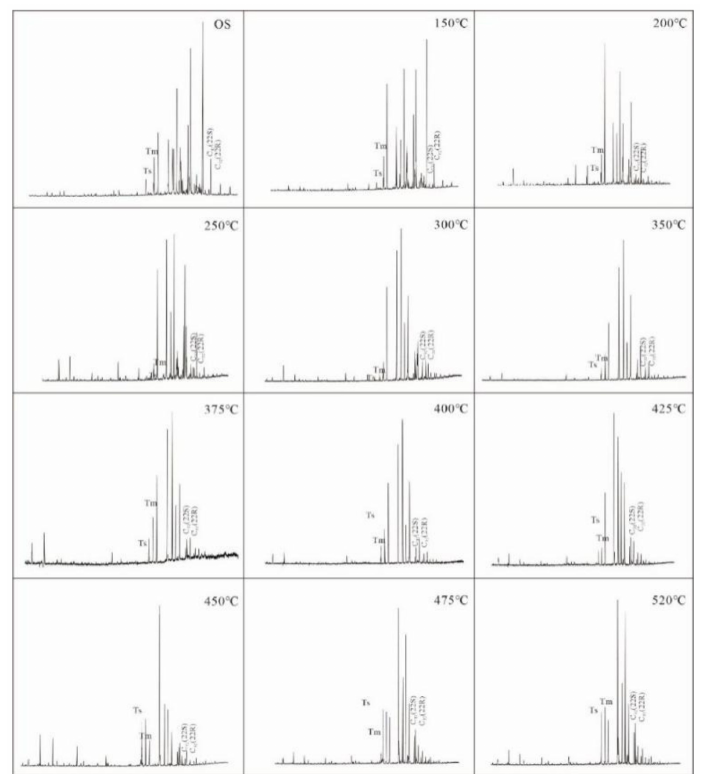
Figure 8. MS at different temperatures with mass chromatogram m / z = 191.